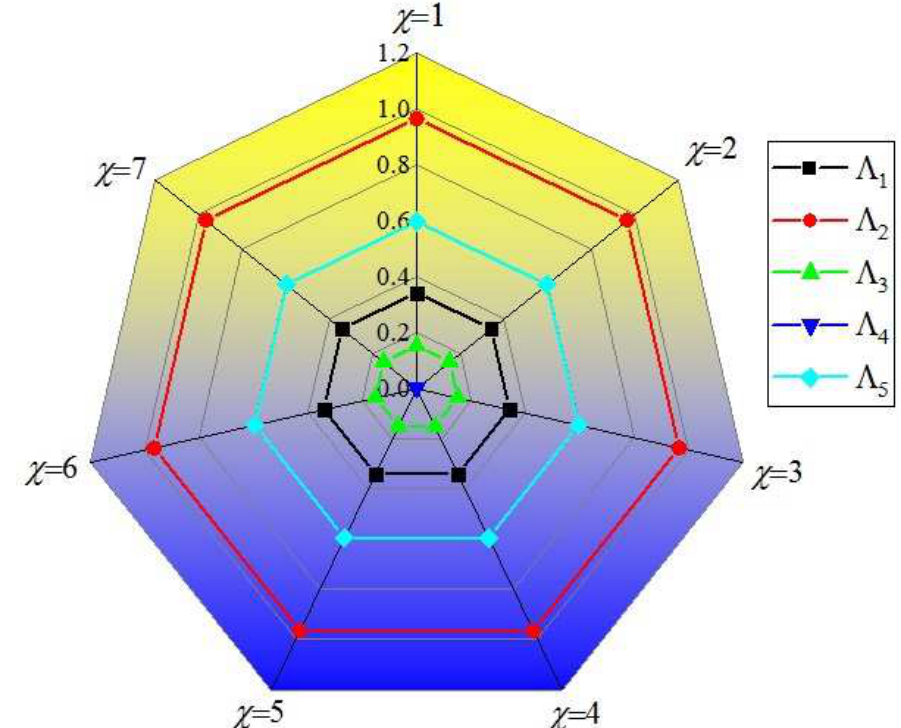
Figure 3. Decision results under different parameters χ for the distance